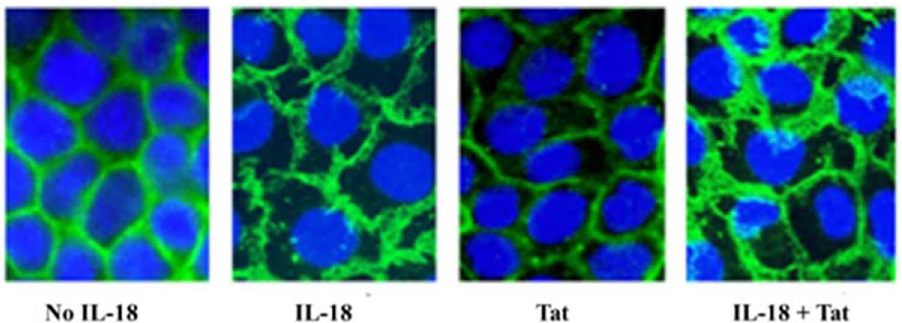
Fig 7. IL-18 disrupts and redistributes β -catenin in adherent junctions in HT-29 monolayers. The HT-29 monolayers were treated with IL-18 (10 ng/ml), Tat (100 ng/ml) or both. After 24 hours, the monolayers were incubated with rabbit anti-human β -Catenin or a control rabbit IgG (obtained from non-immunized animals as a negative control). After washing, the cells were stained with FITC-conjugated goat anti-rabbit antibodies, counterstained with DAPI, washed and examined under a fluorescent microscope. The figure shows typical images from three independent experiments. Note displacement and redistribution of the molecule around individual cells in the